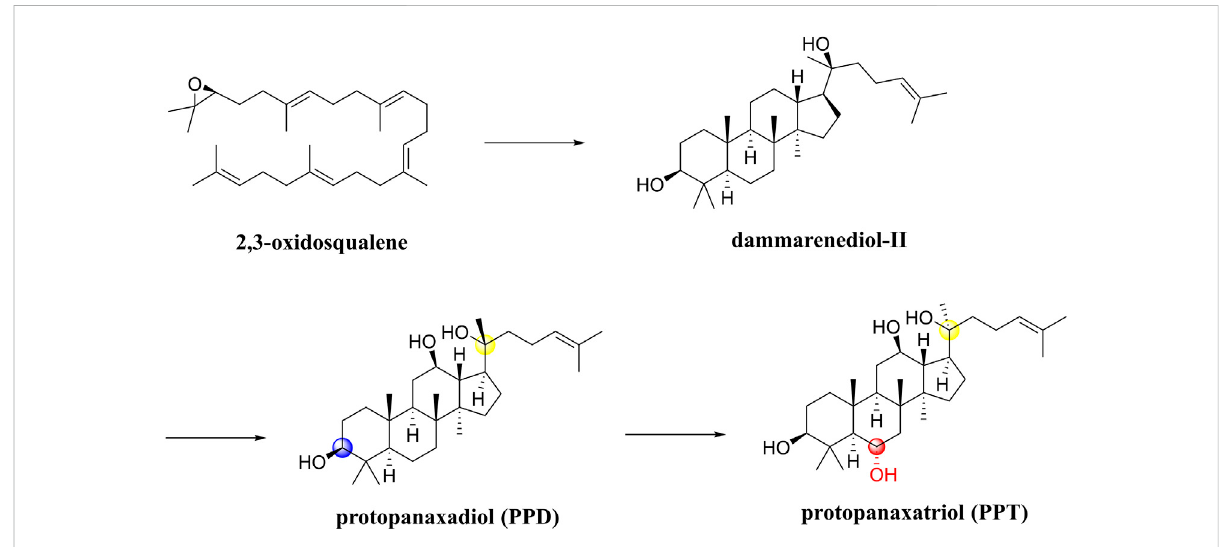
FIGURE 7 Synthetic routes and different types of notoginseng